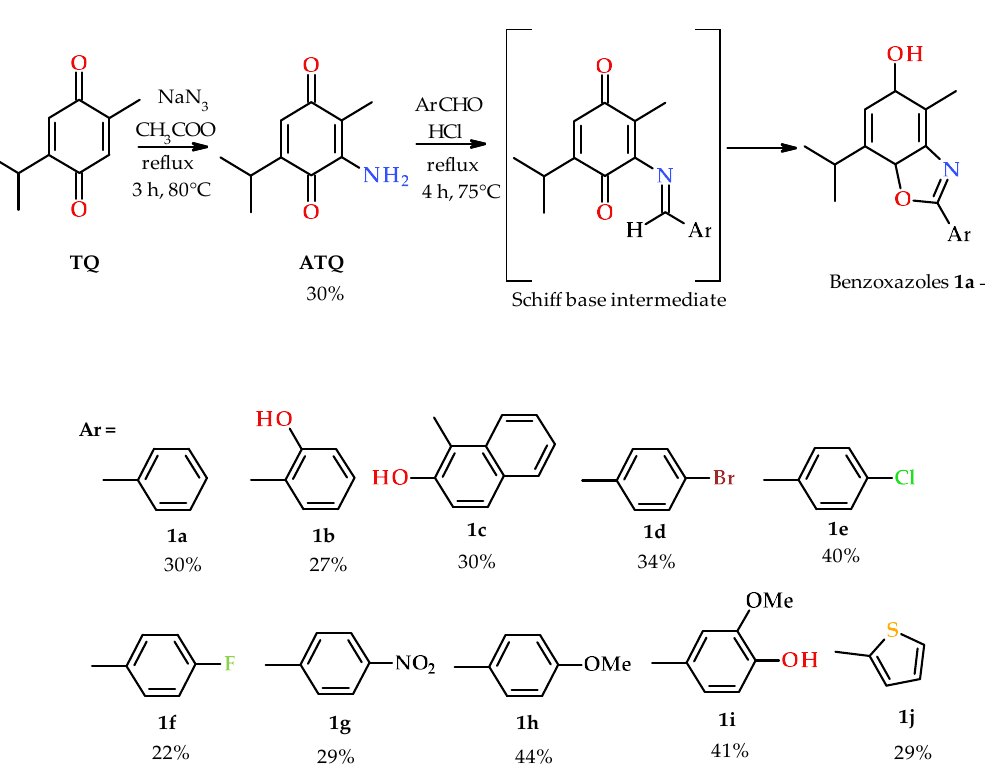
Scheme 1. Synthesis of 3-aminothymoquinone ( ATQ ) and series of benzoxazoles 1a – 1j from